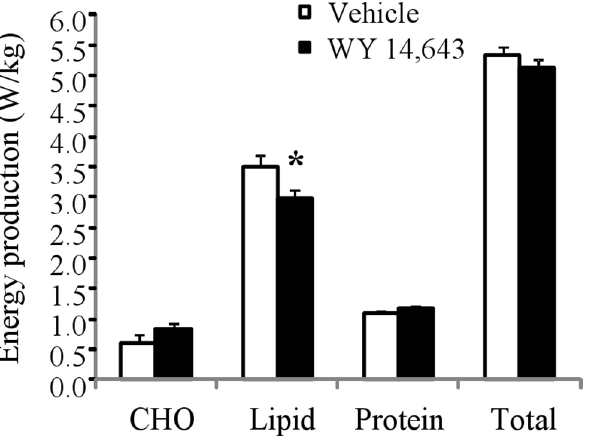
Fig. 5. Estimated energy production from the oxidation of carbohydrate (CHO), lipid and protein, as well as the total energy expenditure (Total). Measurements were done in the fasting state following 4–5 week vehicle or WY 14,643 treatment in the rats. Values are given as means ¡